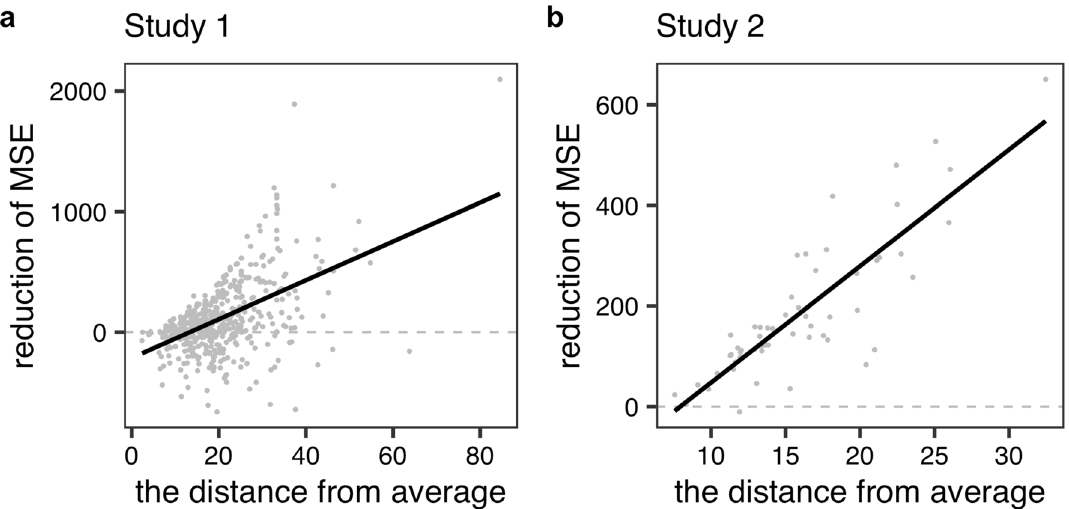
Figure 6. Results of the ‘Individual differences’ section in Study 1( a ) and Study 2( b ). The black lines represent the regression lines. The larger the distance from the average, the larger the reduction of the